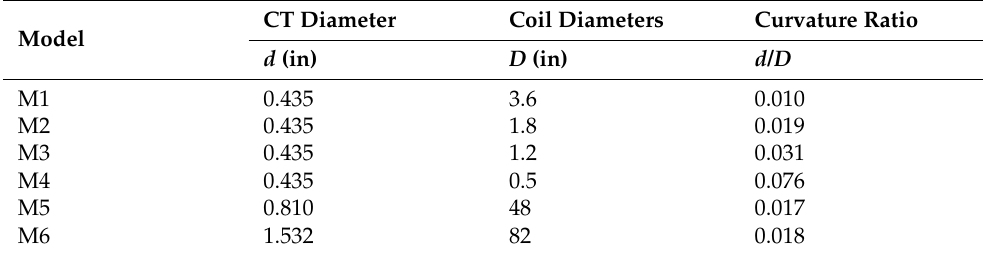
Table 1. Geometric dimensions of coils and tubing.